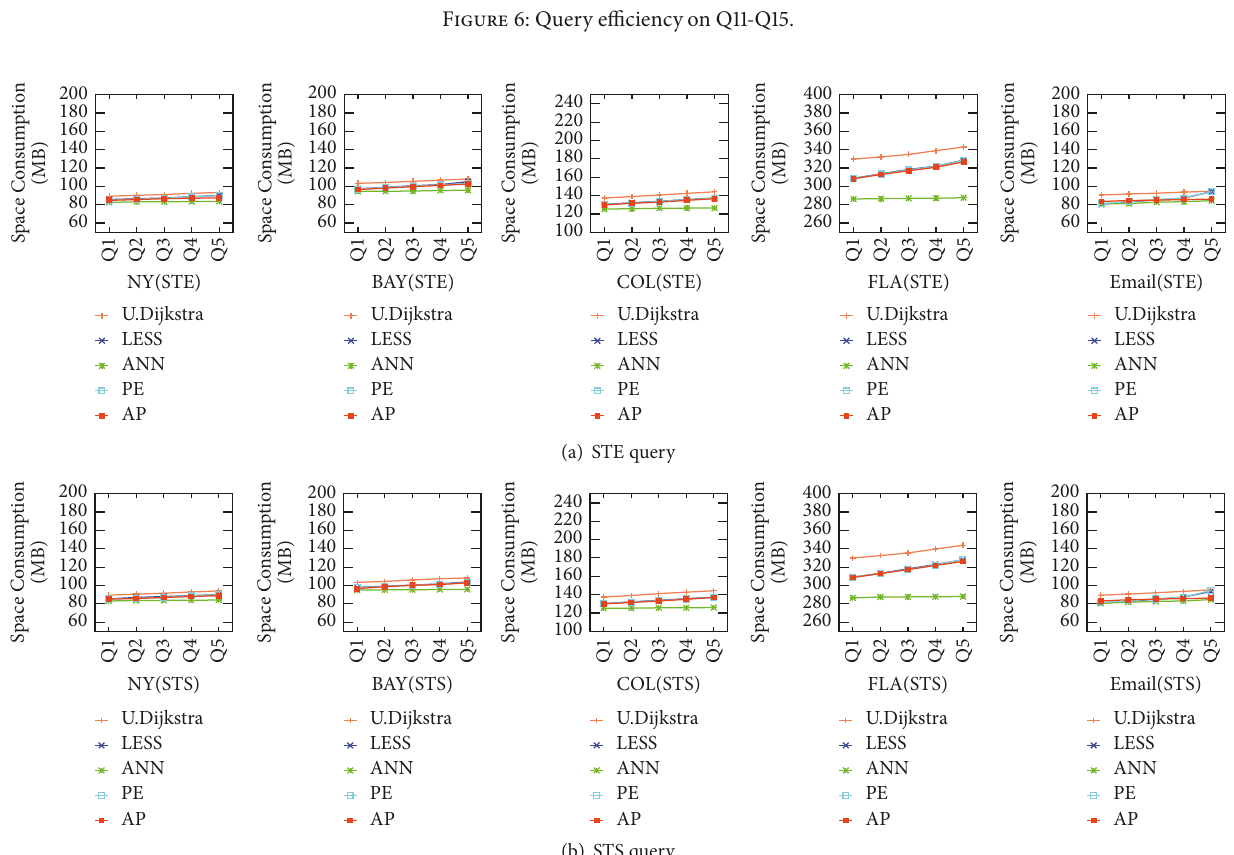
Figure 7: Space consumption on